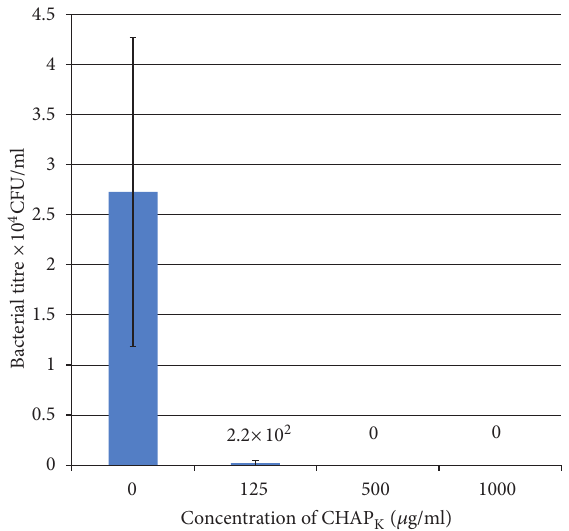
(cid:36)(cid:80)(cid:79)(cid:68)(cid:70)(cid:79)(cid:85)(cid:83)(cid:66)(cid:85)(cid:74)(cid:80)(cid:79) (cid:80)(cid:71) (cid:36)(cid:41)(cid:34)(cid:49) (cid:44) (cid:9) (cid:2484) (cid:72)(cid:16)(cid:78)(cid:77)(cid:10) F 2: Viable plate count assay demonstrating the antimicrobial treatment on 24h bio�lms of S. aureus DPC5246. effect of a CHAP K 24h staphylococcal bio�lms were grown on peg lids in microtitre that were retrieved from plates. e bar chart shows the CFUmL , at the concentrations the pegs aer 4h treatment with CHAP −1 K outlined below each bar. e assay was performed in triplicate and each bar is a representation of the mean SE. e values indicated above the bars are the mean CFU/mL aer F 1: Bio�lm staining assay demonstrating disruption of 24h ± bio�lms of S. aureus DPC5246 aer 4h incubation with CHAP K at concentrations ranging from 3.91–500 g/mL. e assay was carried out in triplicate in a �at bottomed 96-well plate. Absorbance ) are represented in the graph as the readings at 590nm (OD 𝜇𝜇 nm mean SE. Below the graph is a picture of the stain in the wells prior 590 to solubilisation with acetic acid. e wells correspond to the data represented directly above each set. ±